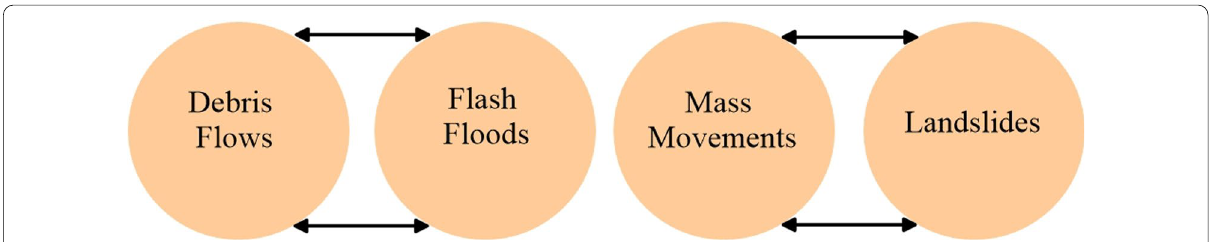
Fig. 1 Cloudburst-triggered hazards in the Uttarakhand